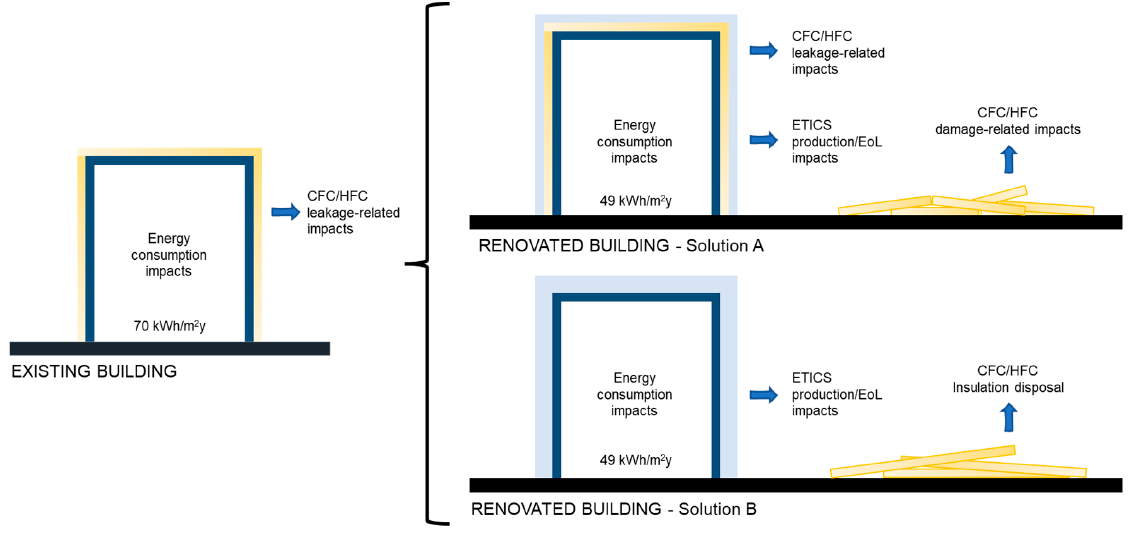
Figure 1. Alternative energy retrofit solutions for the building envelope and related emissions. Solution A: superposition of a new ETICS layer above the existing ETICS layer. Solution B: removal and disposal of the existing ETICS layer and the subsequent addition of a new layer.